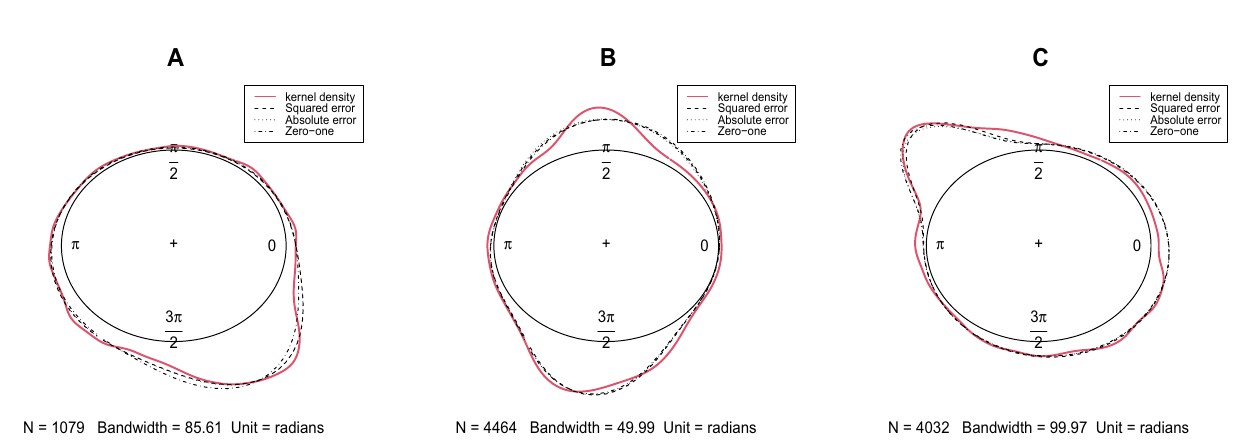
Table 5. Bayes estimates of parameters under different loss functions and corresponding DIC for datasets. The best model is indicated in bold.